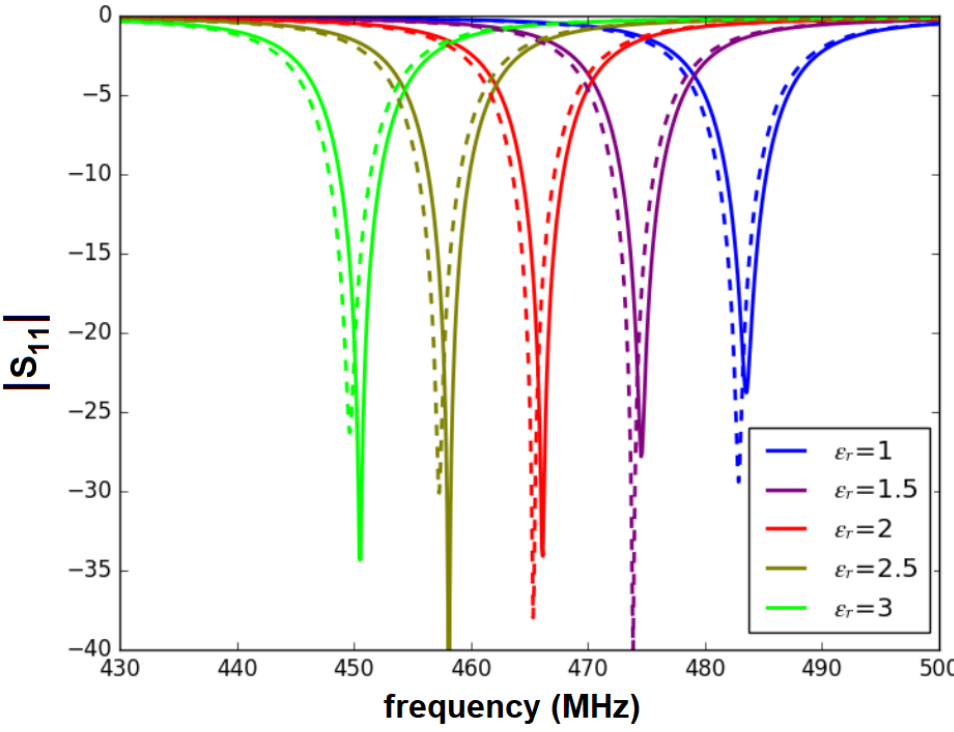
Figure 5. Simulated | S 11 | for the uncovered (solid) and covered (dashed) sensor. Fluids of permittivi- ties between 1 and 3 are